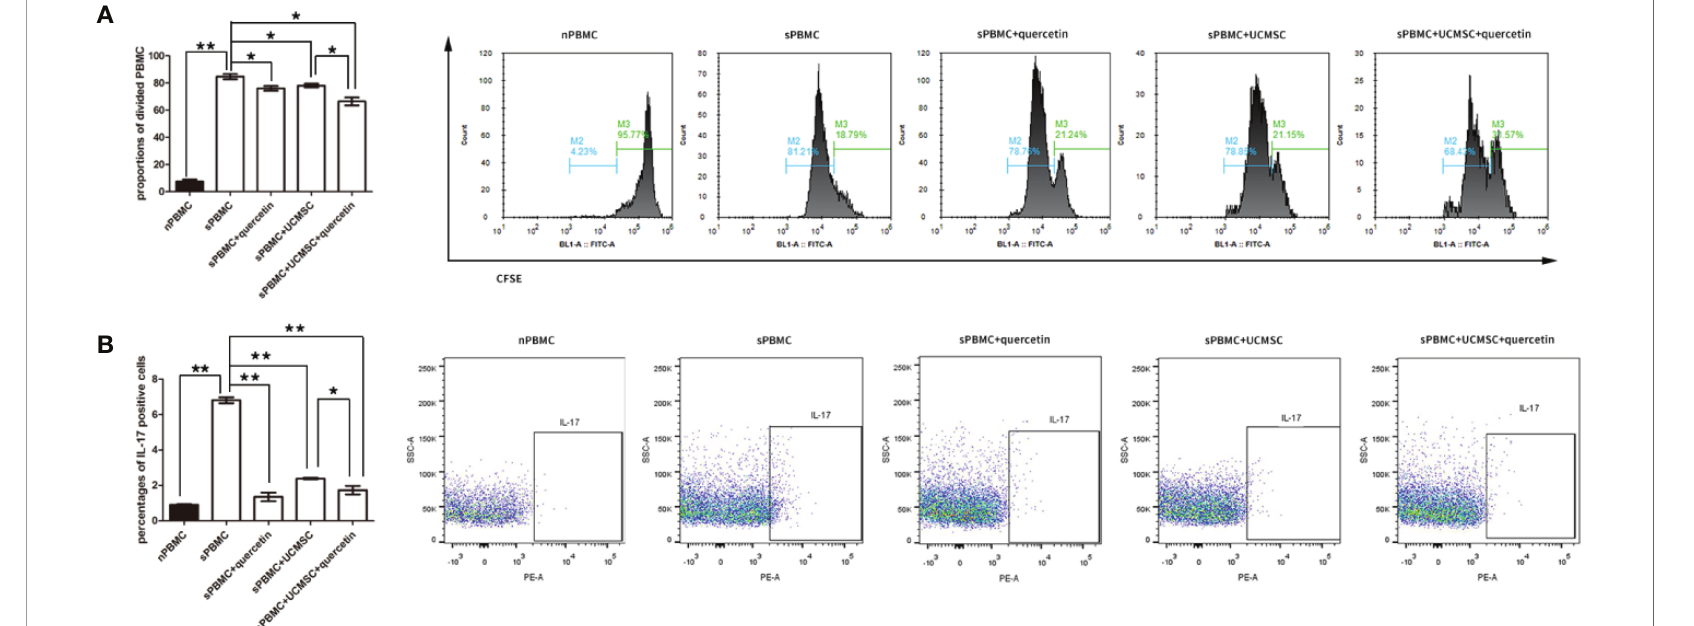
FIGURE 3 | Quercetin enhanced UCMSC immunomodulation. UCMSCs were cocultured with TNF- a /IFN- g -activated PBMCs (1:1 ratio) for 3 days. (A) CFSE-labeled PBMCs were cocultured with UCMSCs that were treated with or without quercetin for 3 days, and PBMC proliferation was determined by the proportions of attenuated CFSE- fl uorescent cells (divided cells). Both UCMSCs and quercetin suppressed PBMC division, and UCMSCs and quercetin acted on PBMCs additively; they had a combined inhibitory effect on PBMC division. Mean ± SEM, n = 3, * P < 0.05, ** P < 0.01. (B) Th17 cells were measured by IL-17- positive cells from puri fi ed CD4+ T cells. Quercetin and UCMSCs alone or in combination inhibited the proliferation of Th17 cells, and quercetin enhanced the suppressive effect of UCMSCs when UCMSCs were pretreated before coculture. Mean ± SEM, n=3, *P < 0.05, ** P <